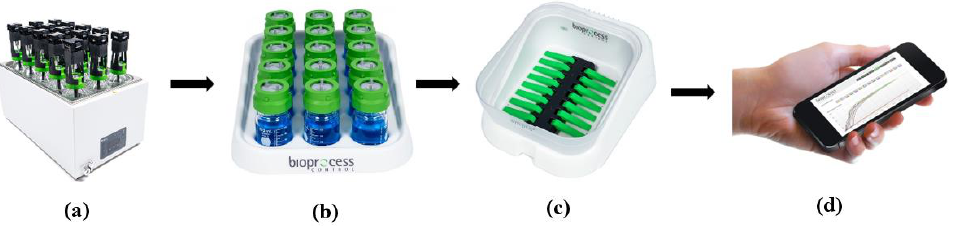
Figure 3. The anaerobic batch respirometric reactors (AMPTS II) used in stage 1 of the study, including: ( a ) anaerobic incubation unit; ( b ) ex situ CO 2 absorption unit; ( c ) CH 4 production measurement unit; ( d ) software with a data collection and analysis